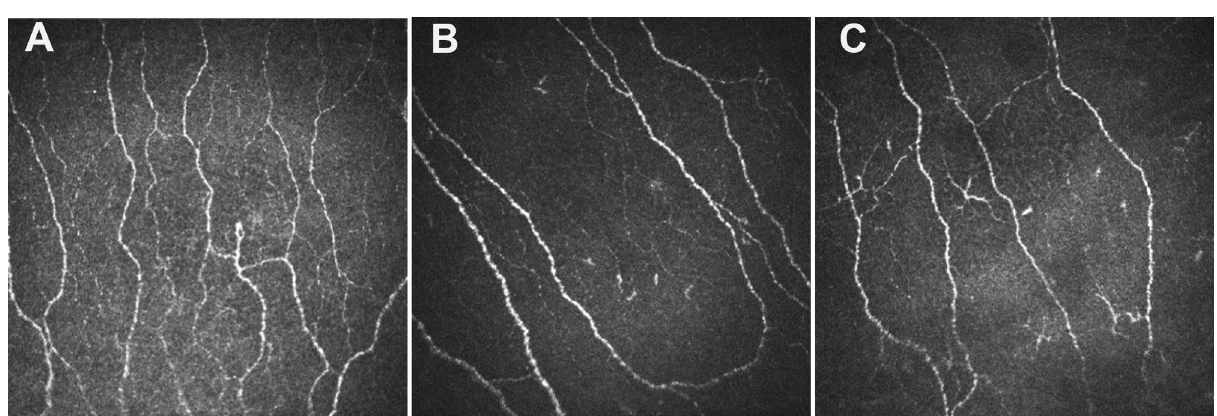
Figure 2. Dot plots of corneal endothelial cell (EC) parameters: ( A ) endothelial cell density, ( B ) endothelial cell area, ( C ) endothelial cell perimeter, ( D ) endothelial cell polymegathism ( E ) and endothelial cell pleomorphism in patients with poor compared to moderate-good collaterals.